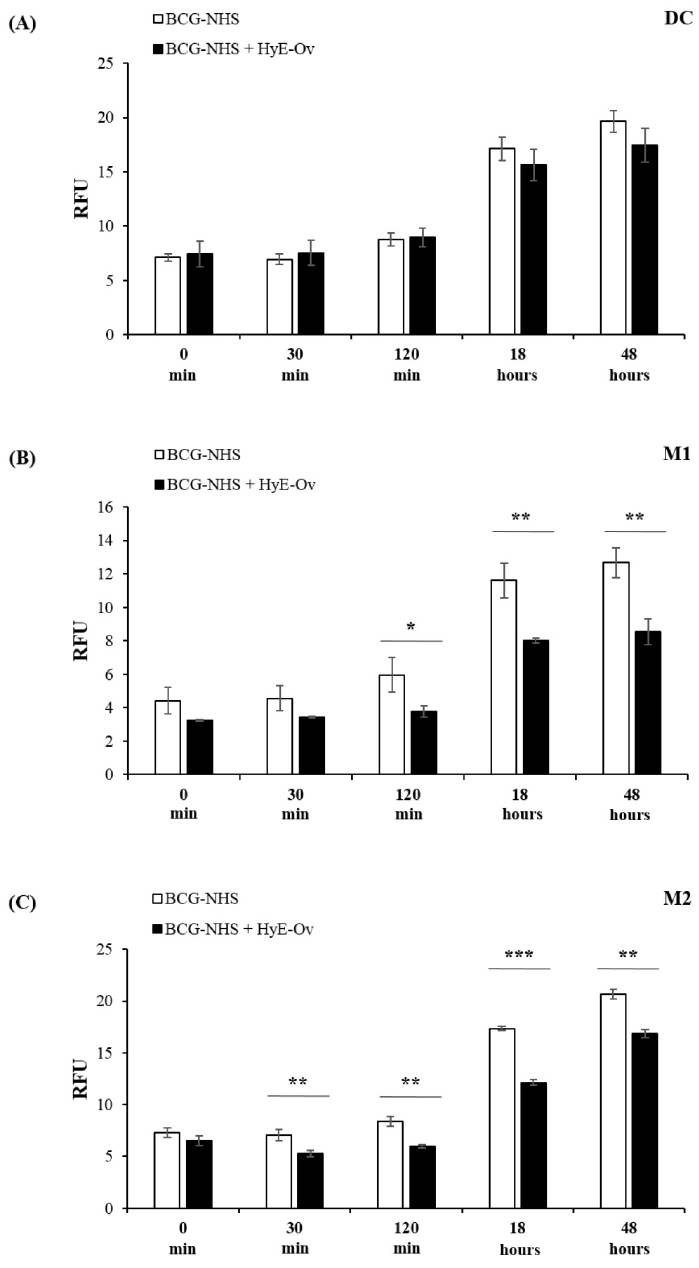
Fig 2. HyE-Ov promotes phagosome acidification. DC (A), M1 (B) and M2 (C) cells (10 6 /well) were infected with BCG conjugated with NHS (MOI 5) for 3 hours and then stimulated with HyE-Ov (3 mg/ml of equivalent plant material). Results are expressed as means ± SD of Relative Fluorescent Units (RFU) of triplicate culture values and are representative of at least 3 independent experiments on cells from different donors. � p < 0.05, �� p < 0.01 and ��� p < 0.0001 in comparison with non-stimulated infected